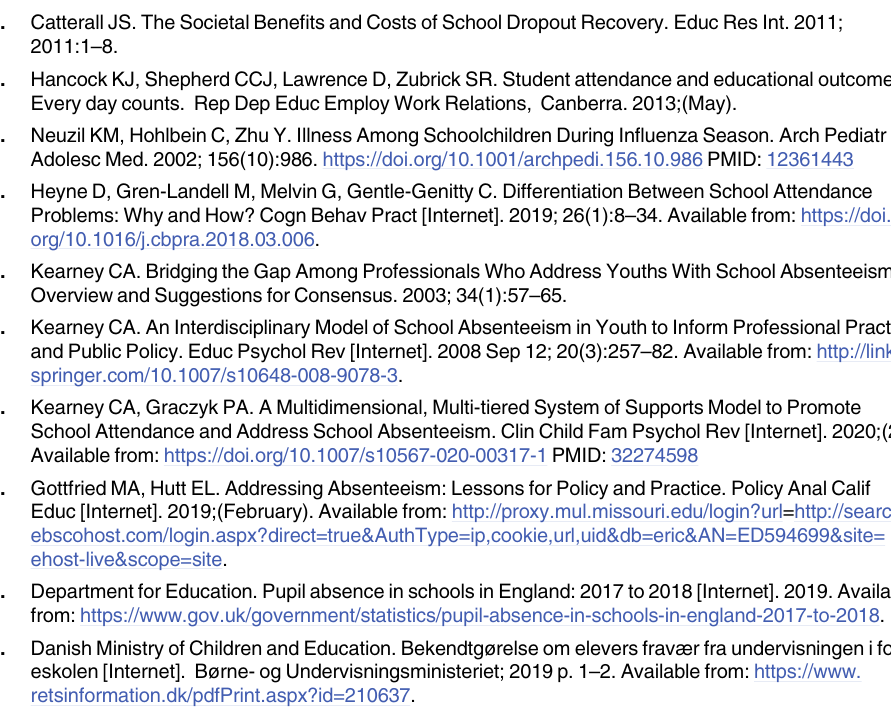
S1 Table. Mean and standard deviations from youth and parent ratings on all total scales and sub-scales of SCAS, MFQ, and SDQ grouped by gender and age group.